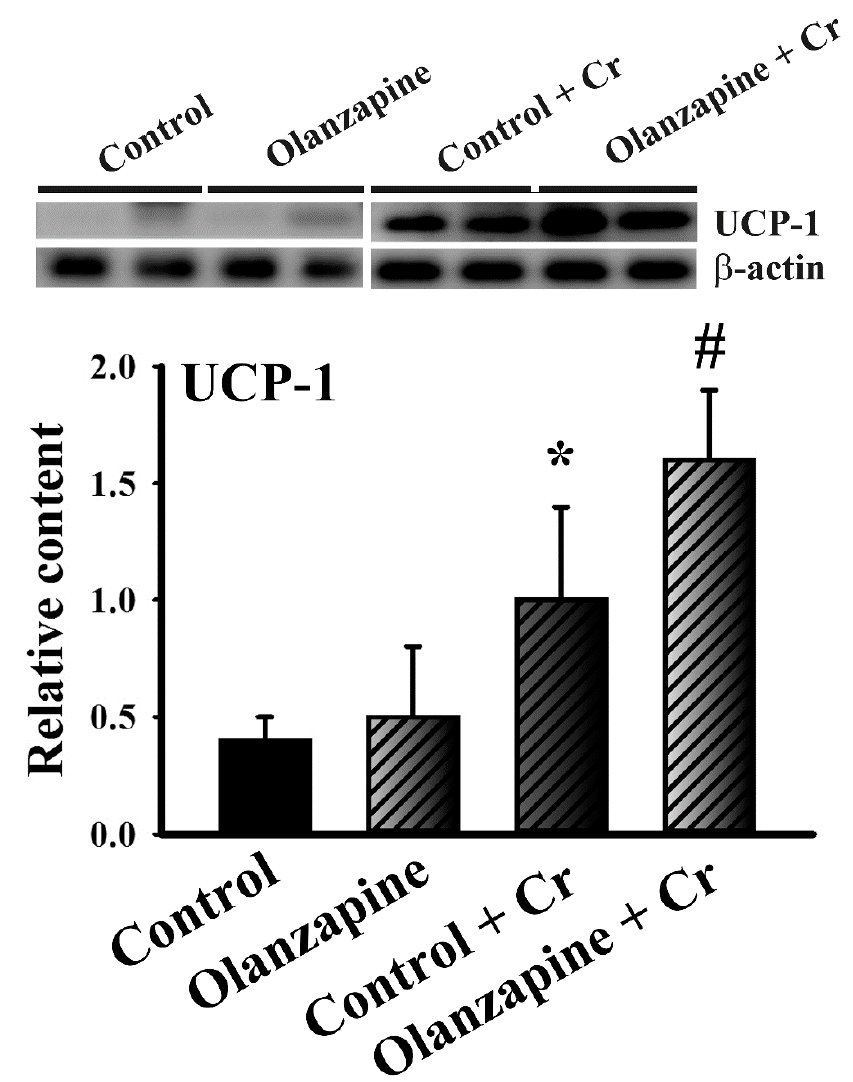
Figure 7. Chromium increased uncoupling protein-1 (UCP-1) expression in white adipose tissues. Proteins were extracted from the excised white adipose tissues (including inguinal, periovarian, mesentery, and perirenal fat) and subjected to Western blotting with indicated antibodies. Two representative blots of 10 rats were shown and the quantitative data were depicted. * p < 0.05 vs. control and # p < 0.05 vs. olanzapine control, n =